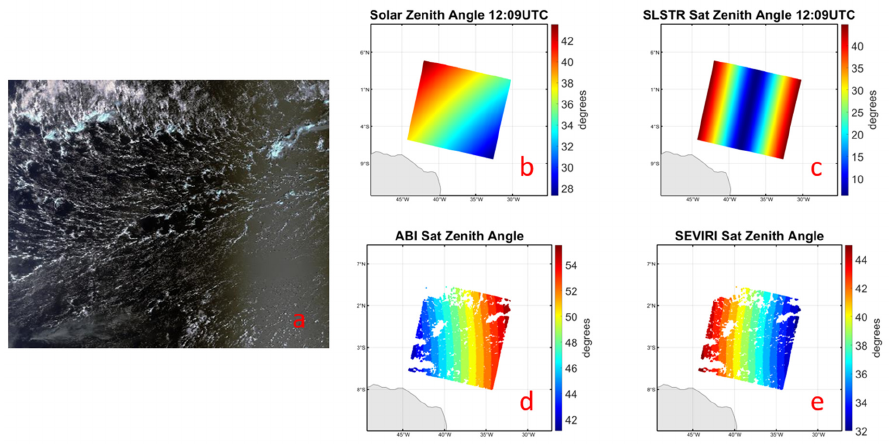
Figure 15. ( a ): SLSTR daytime false color infrared image of the cross-covered region on 27 November 2019, 12:09 UTC. ( b ): Solar zenith angles data at the same time. Corresponding SLSTR ( c ), ABI ( d ), SEVIRI ( e ) satellite zenith angles data.